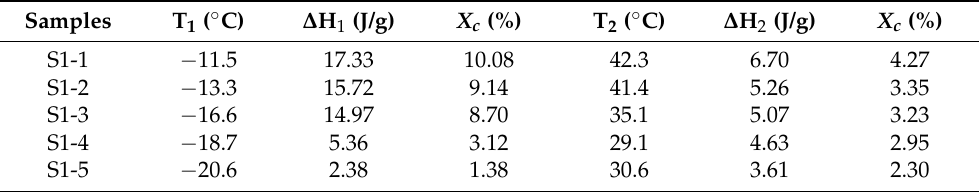
Table 4. Melting enthalpy and crystallinity of elastomers with different R value.